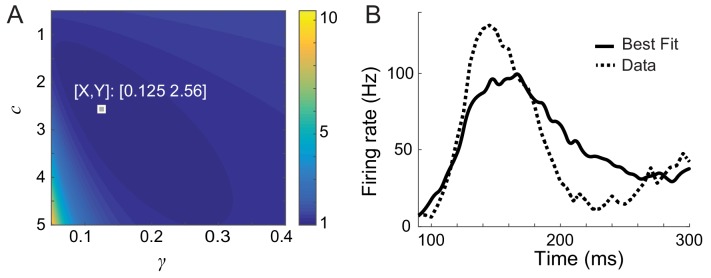
Short-term depression cannot reproduce a damped oscillation after learning.(A) Parameter search of the strength of depression (γ) and strength of potentiation (c = fmRgmR). The color map shows the distance between the data and simulation of the response for familiar stimuli normalized by the lowest distance. (B) Time course of the response to the best familiar stimuli with the best-fitted parameters γ = 0.125, and fmRgmR = 2.56. Other parameters are τR = 5 ms, τx = 200 ms, and ImX is obtained from the response to the best novel stimuli.